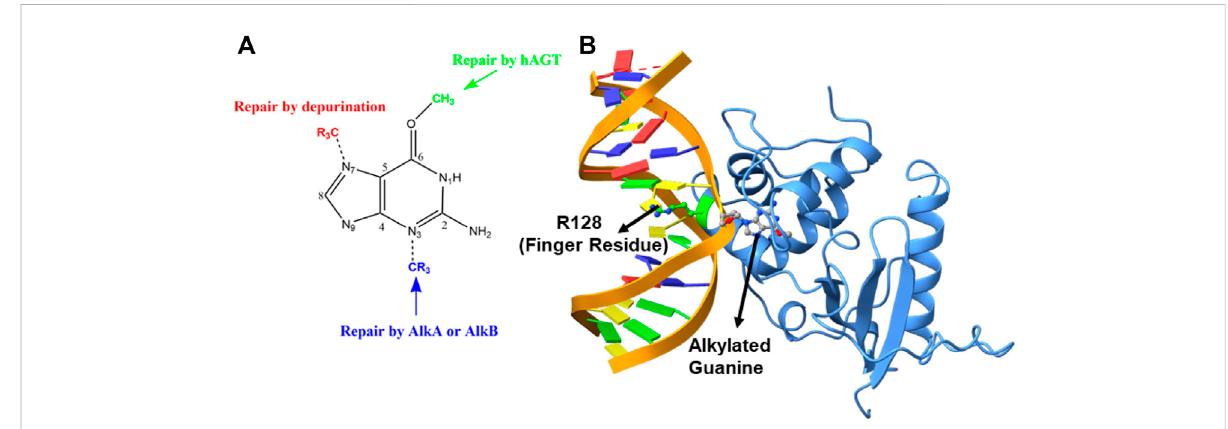
FIGURE 1 (A) DNA repair mechanism based on the position of alkylation. (B) Structure of the fl ipped alkylated guanine in hAGT (PDB ID